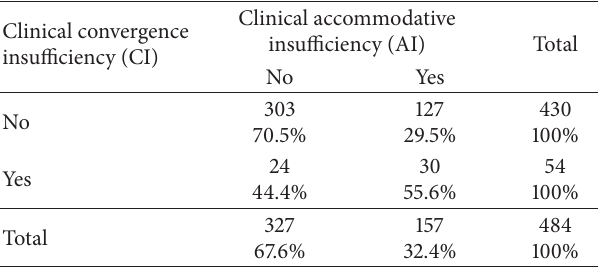
Table 2: Relation between clinical convergence insufficiency (3 clinical signs present) and clinical accommodative insufficiency. Clinical convergence